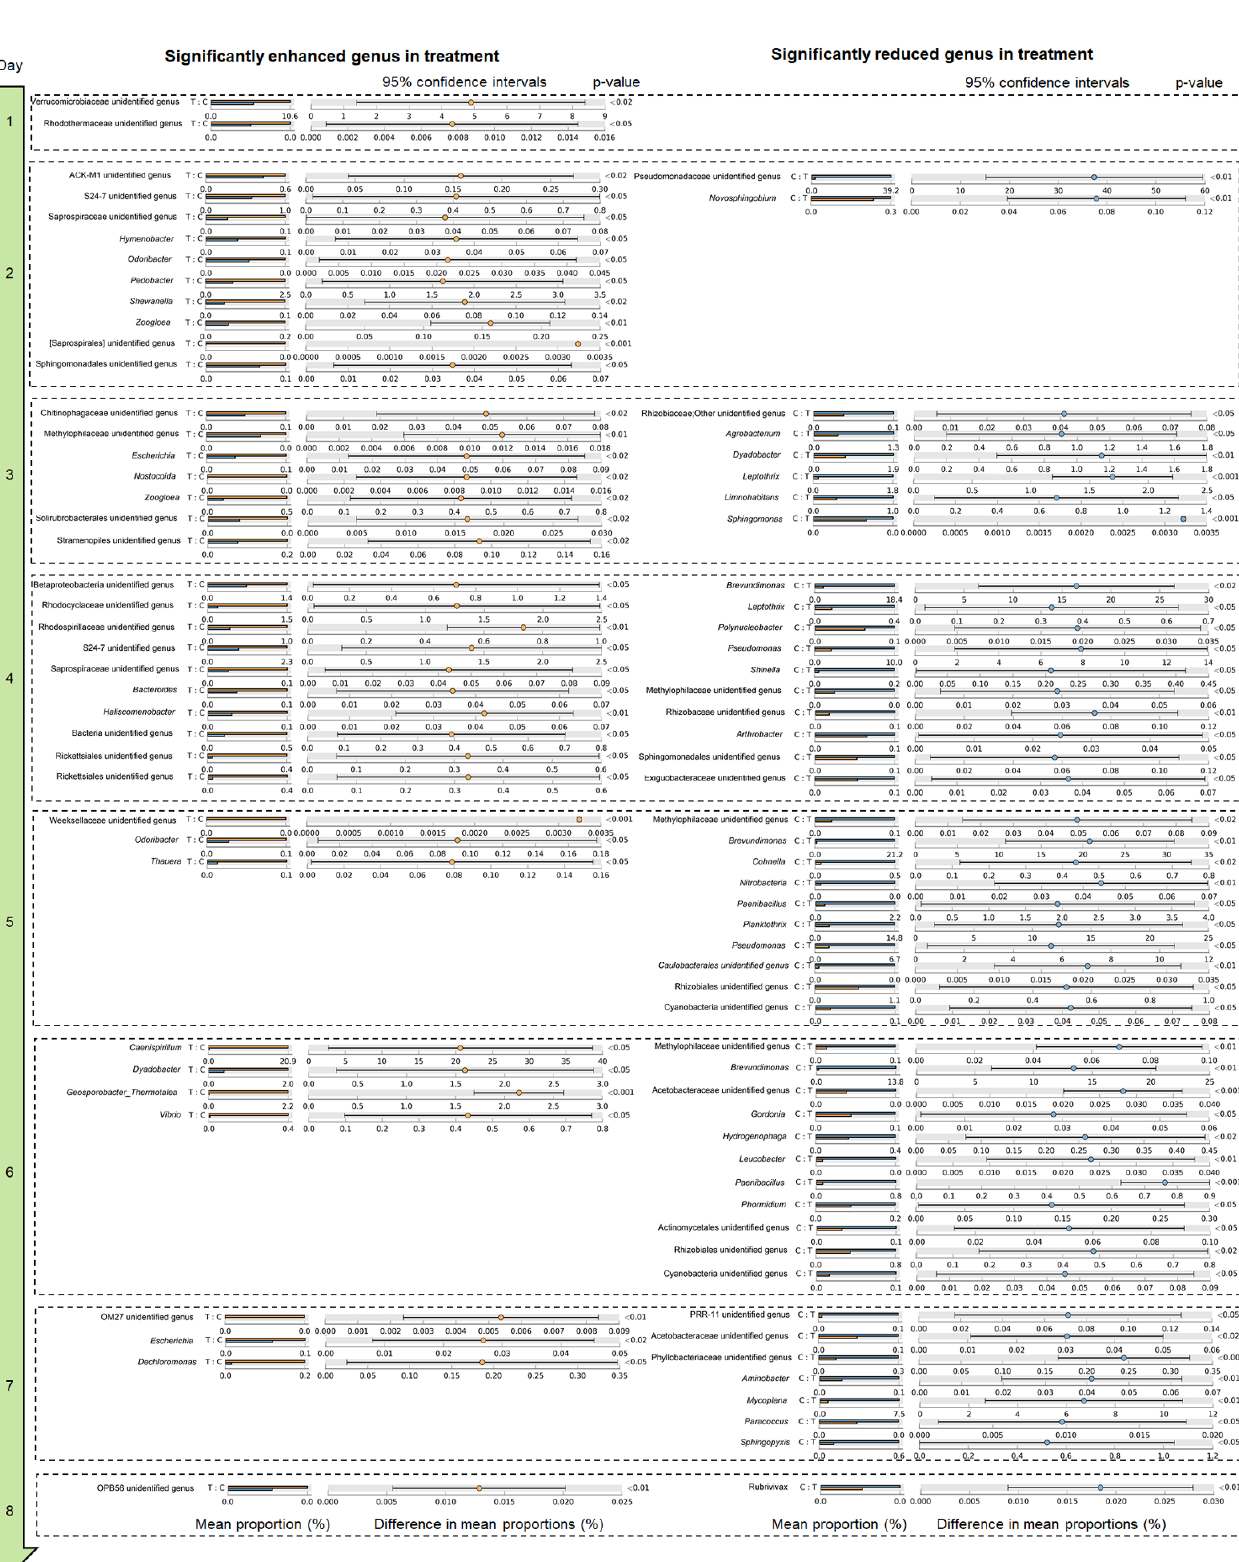
Figure 3. Differences in water microbiota between the treatment and control groups at different days following the start of the experiment. Post-hoc plots were created using the statistical analysis of metagenomic profiles software.